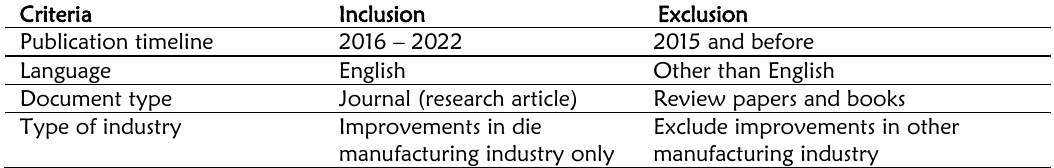
Table 4: Inclusion and exclusion